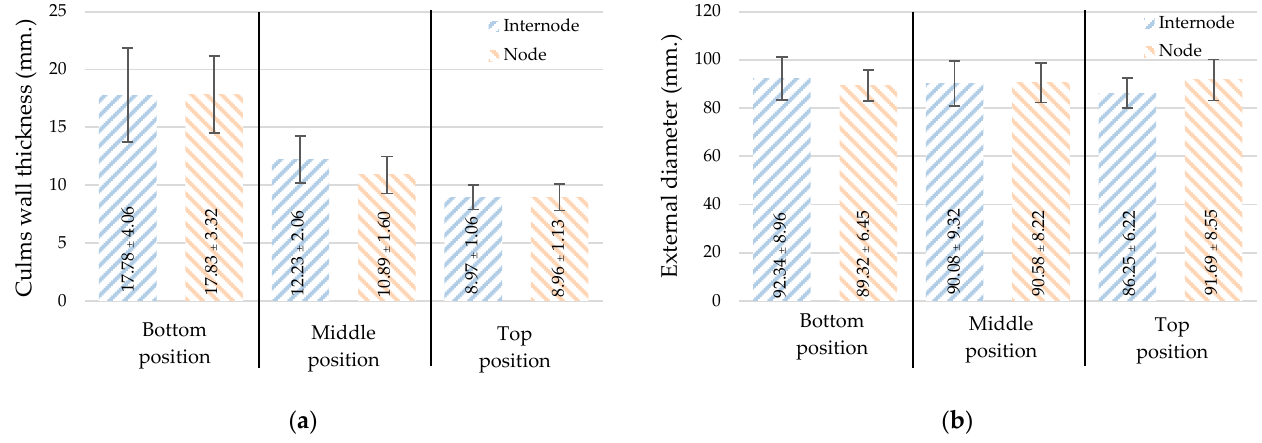
Figure 5. Dimensions: ( a ) culm wall thickness and ( b ) External diameter (mean ± standard devia- tion).